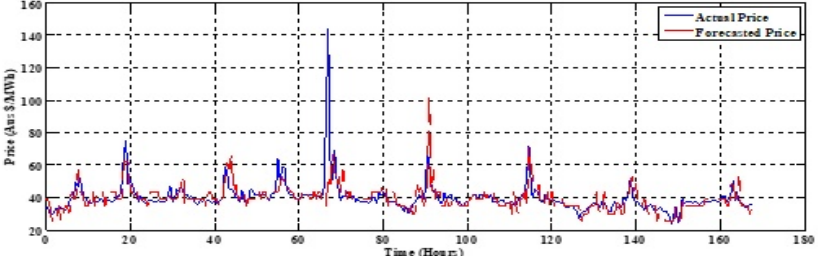
Figure 7. September 8–14, 2015 forecasting without feature selection in the spring season (MAPE = 10.05).